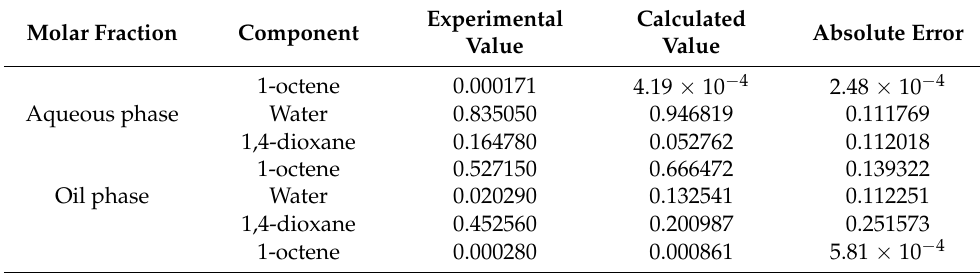
Table 3. Comparison of experimental and calculated values of liquid–liquid two-phase in 1-octene– water–1,4-dioxane system at 55 ◦